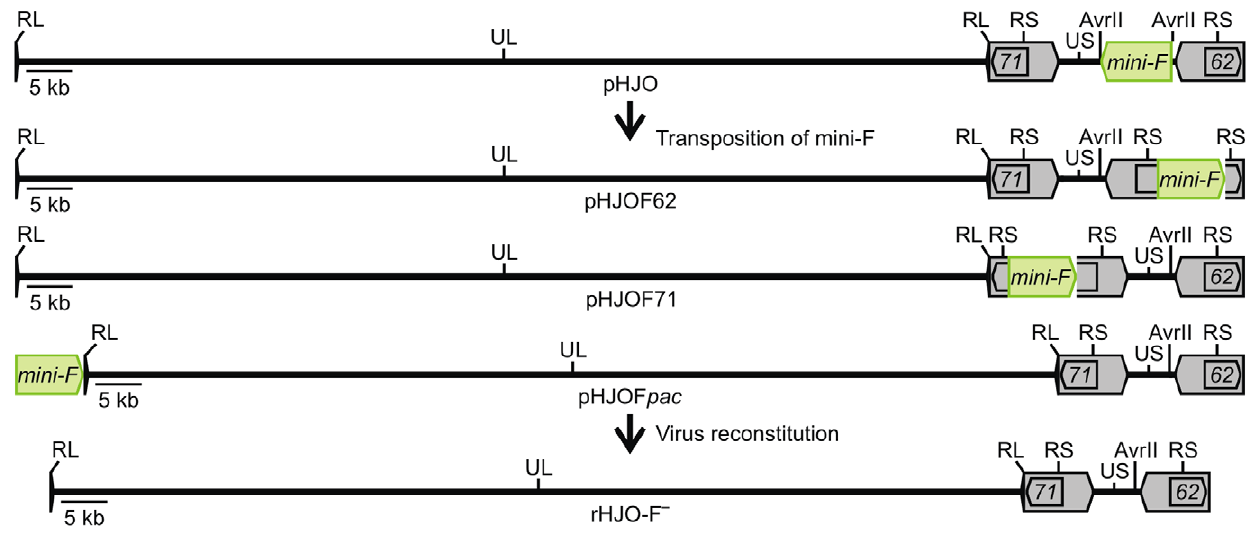
Figure 2. Infectious BAC clones with genome-intrinsic releasable mini-F sequences. Scheme of the generation of pHJO variants with mini- F sequences (green) releasable by intrinsic genome replication processes. Upon mini-F transposition in E. coli , the vector sequences were shifted within the BAC-cloned HJO genome (pHJO) from the unique AvrII site of the US region (reverse with respect to UL, regarding the defined VZV prototype genome organization) into ORF62 , ORF71 , or directly into genomic terminal junction of VZV, to generate pHJOF62, pHJOF71, or pHJOF pac , respectively. Virus reconstitution from the pHJO variants yielded vector-free progeny rHJO-F - .